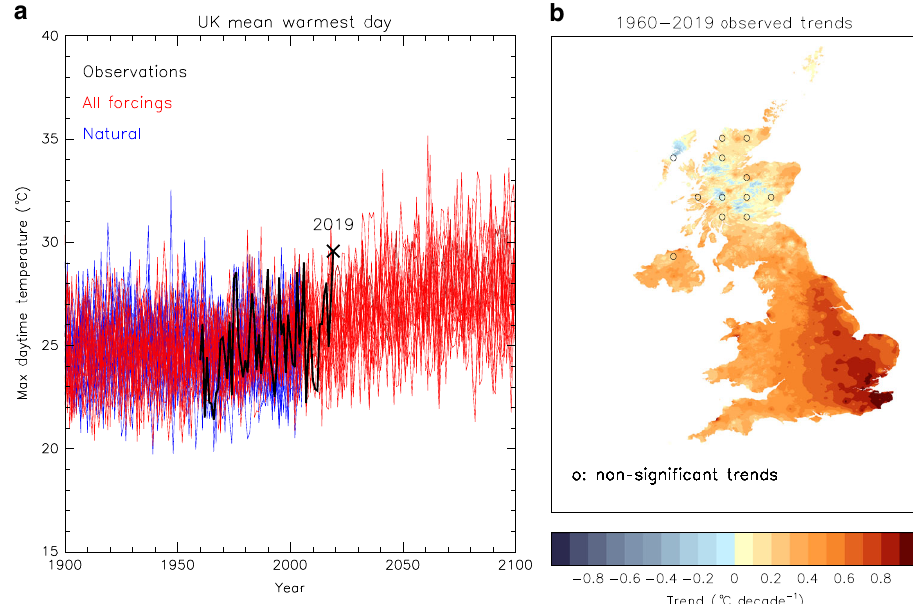
Fig. 1 Warmest daytime temperatures ( tx01 ) in the UK. a Timeseries of the UK mean tx01 from HadUK-Grid observations (black line), and simulations with 16 CMIP5 models with all climatic forcings (red lines) and natural forings only (blue lines). The observed value in 2019 is marked with a cross. Simulations of future years follow the RCP 4.5 scenario. The model data were bias-corrected to have the same mean during a reference period as the observations. b A map of the tx01 trends during 1960 – 2019 computed with HadUK-Grid data. Circles mark areas (of ~60 × 60 km) where most grid boxes have trends not signi fi cantly different from zero (tested at the 10% level), as determined by a Mann – Kendall